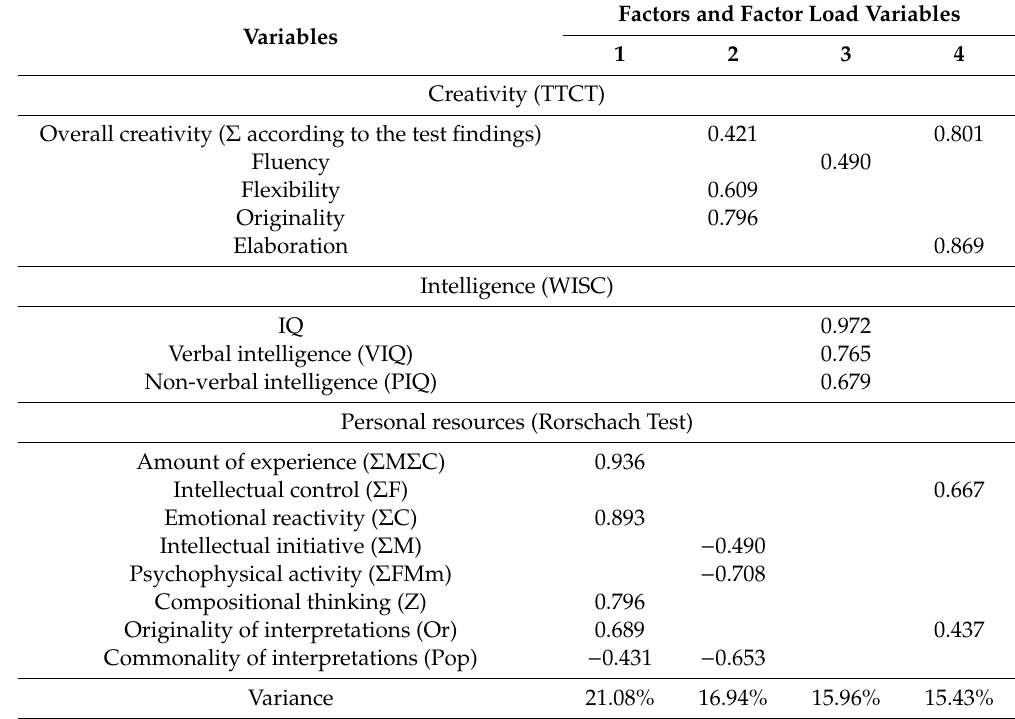
Table 5. Structure of children’s creativity, intelligence, and personal resources, Group